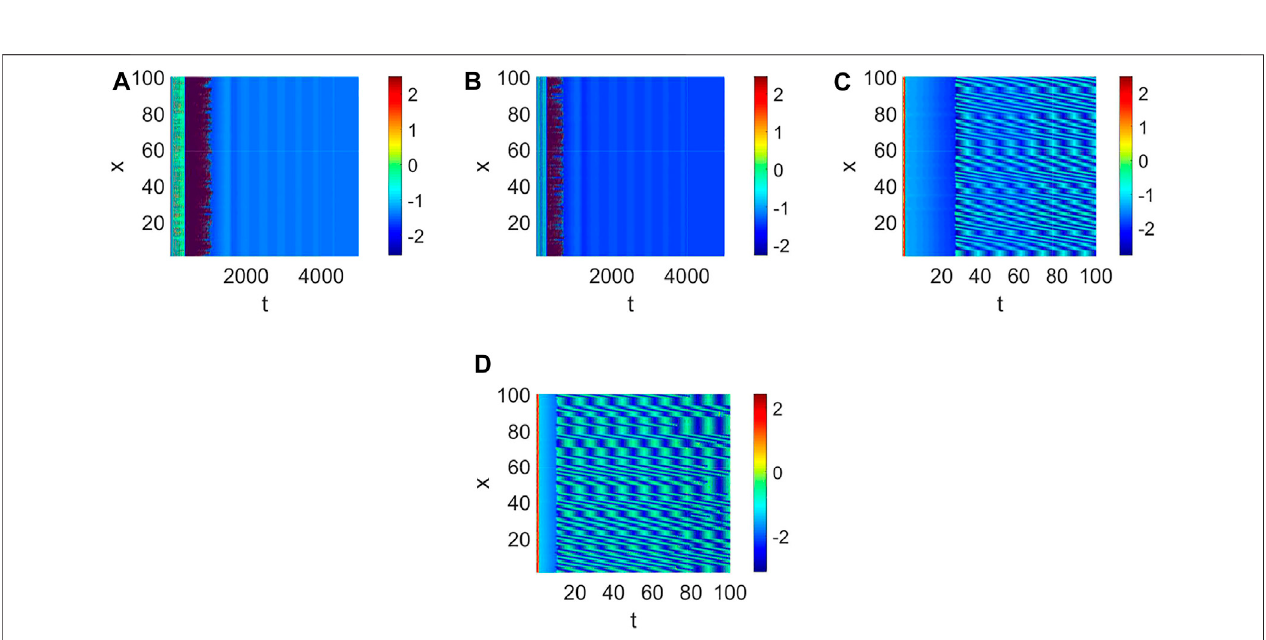
FIGURE8| Thepatternformationofsystem(1)when τ =65. (A) Thepatternformationwhen p =0.05, q =0. (B) Thepatternformationwhen p =0.1, q =0. (C) The pattern formation when p = 0.1, q = 0.96. (D) The pattern formation when p = 0.15, q = 0.96.